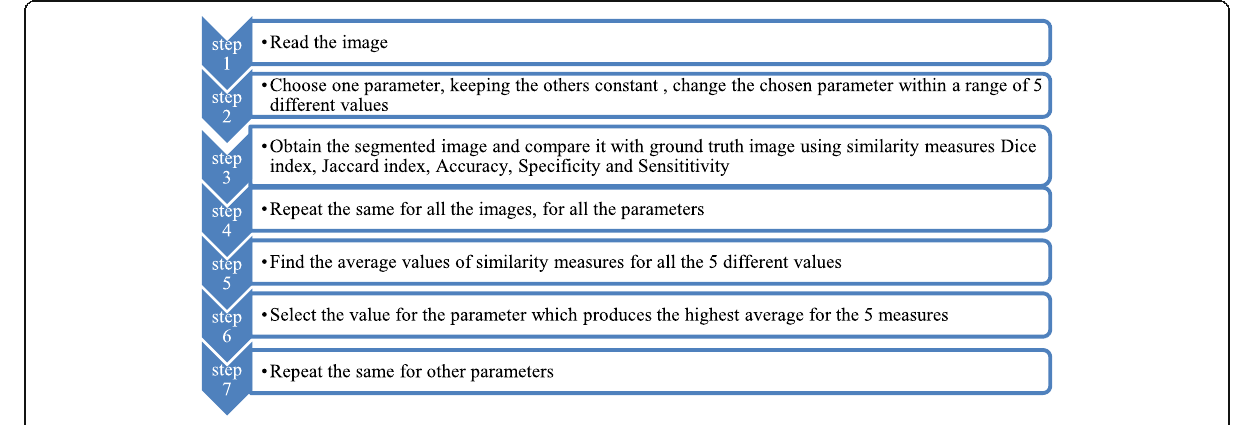
Fig. 1 The flowchart for parameter